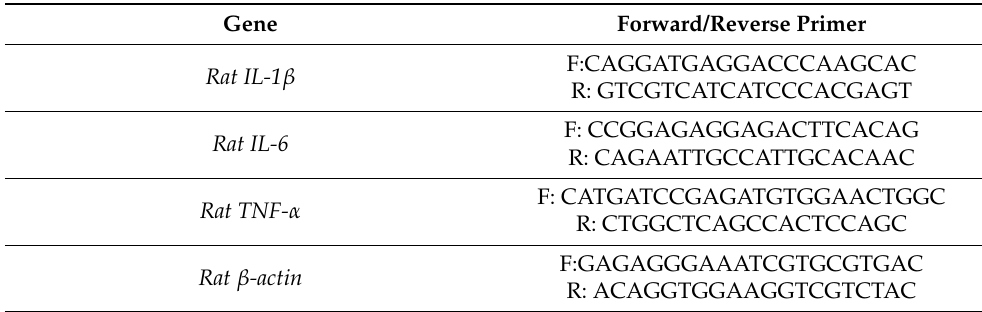
Table 2. Primer sequences for qRT-PCR in